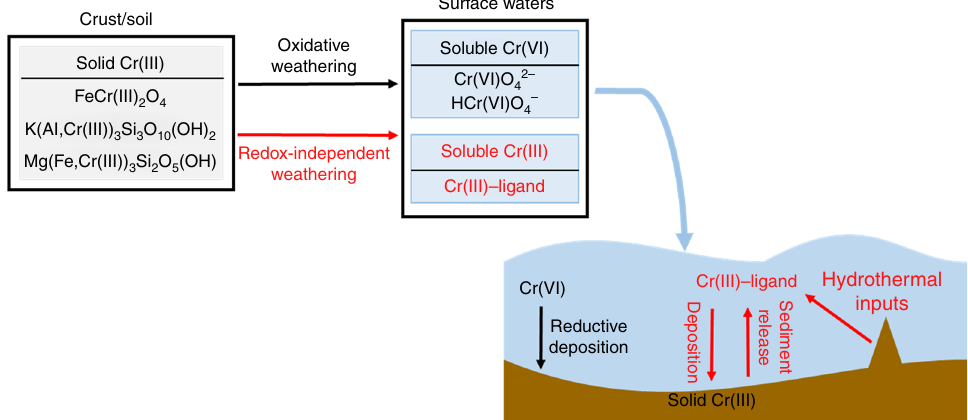
Fig. 7 Suggested updated Cr cycle. Schematic of Cr cycle as a paleobarometer for atmospheric oxygen level. Red text and arrows indicate pathways contributing to isotope fractionation that are currently unconstrained, but important in calibration of this